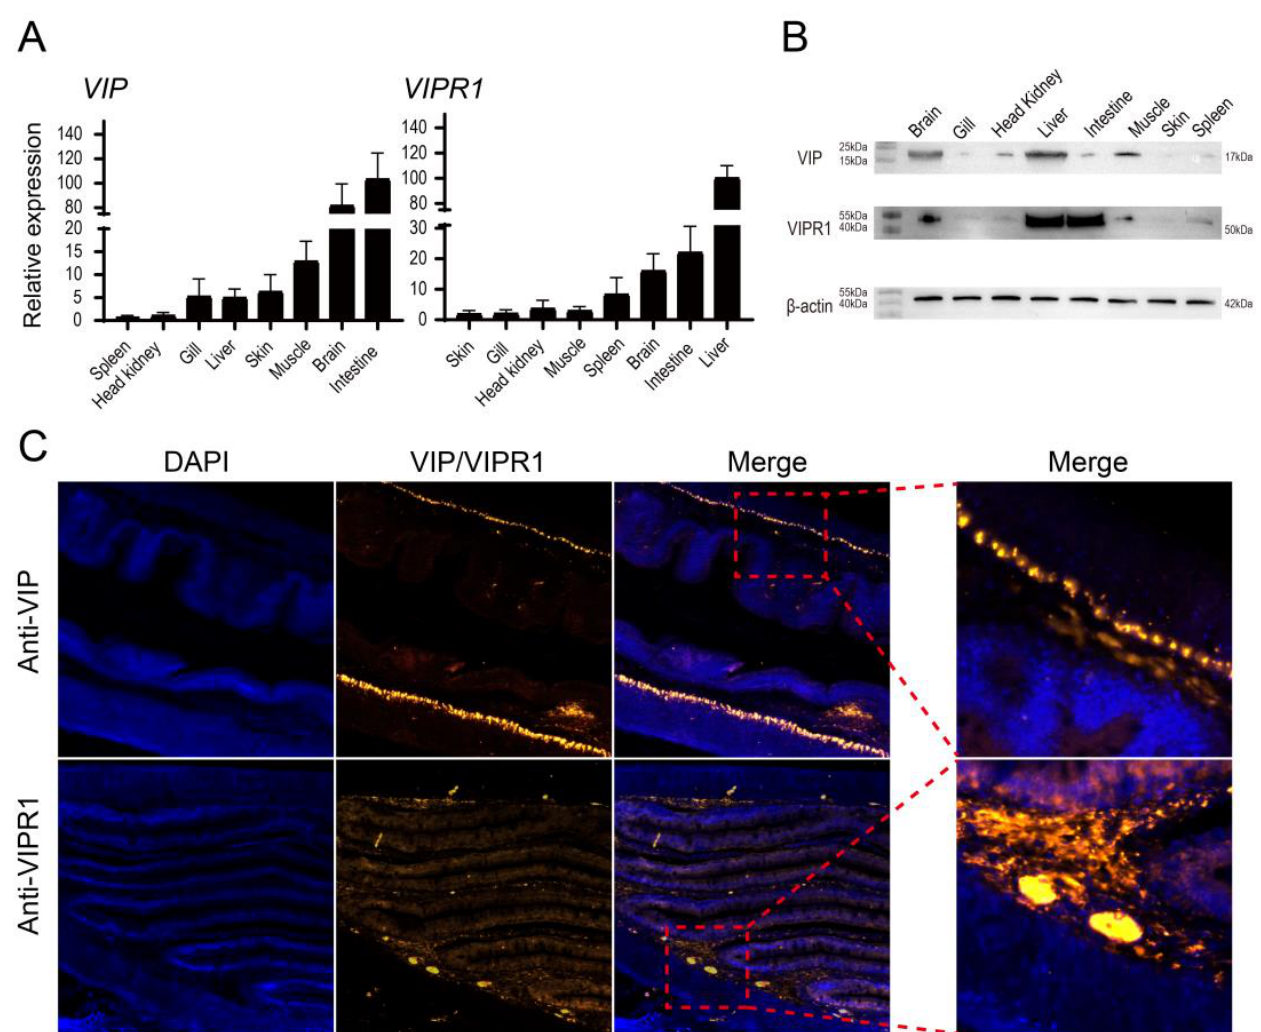
Figure 2. ( A ) By using qRT-PCR, the transcription level of On-VIP and On-VIPR1 in various organs of unchallenged and healthy tilapia was identified. Every value is presented as a mean and standard deviation; n = 3. The transcriptional levels of On-VIP and On-VIPR1 in the spleen and skin were set as 1, respectively. ( B ) By using Western blot, the protein level of On-VIP and On-VIPR1 in various organs of unchallenged and healthy tilapia were assessed. ( C ) The location of On-VIP and On-VIPR1 in the intestine of unchallenged and healthy tilapia. The results were observed using the ZEISS Axioscope 5 microscope with × 200 and × 400 magnifications (Zeiss, Jena, Germany). Western blot was applied to assess the expression patterns of On-VIP and On-VIPR1 at protein levels in unchallenged and healthy tilapia. The protein level of On-VIP was high in liver and brain, followed by muscle and head kidney, and the lowest was observed in spleen. The protein level of On-VIPR1 was high in liver and intestine, followed by brain and muscle, and the lowest in skin (Figure 2B). Additionally, fluorescent immunohistochemistry was applied to detect the distribution patterns of On-VIP and On-VIPR1 in healthy tilapia intestine. The remarkable positive signals of On-VIP were observed in the longitudinal muscle layer of healthy tilapia intestine, while On-VIPR1 was predominantly detected in the mucosal epithelium of healthy tilapia intestine (Figure